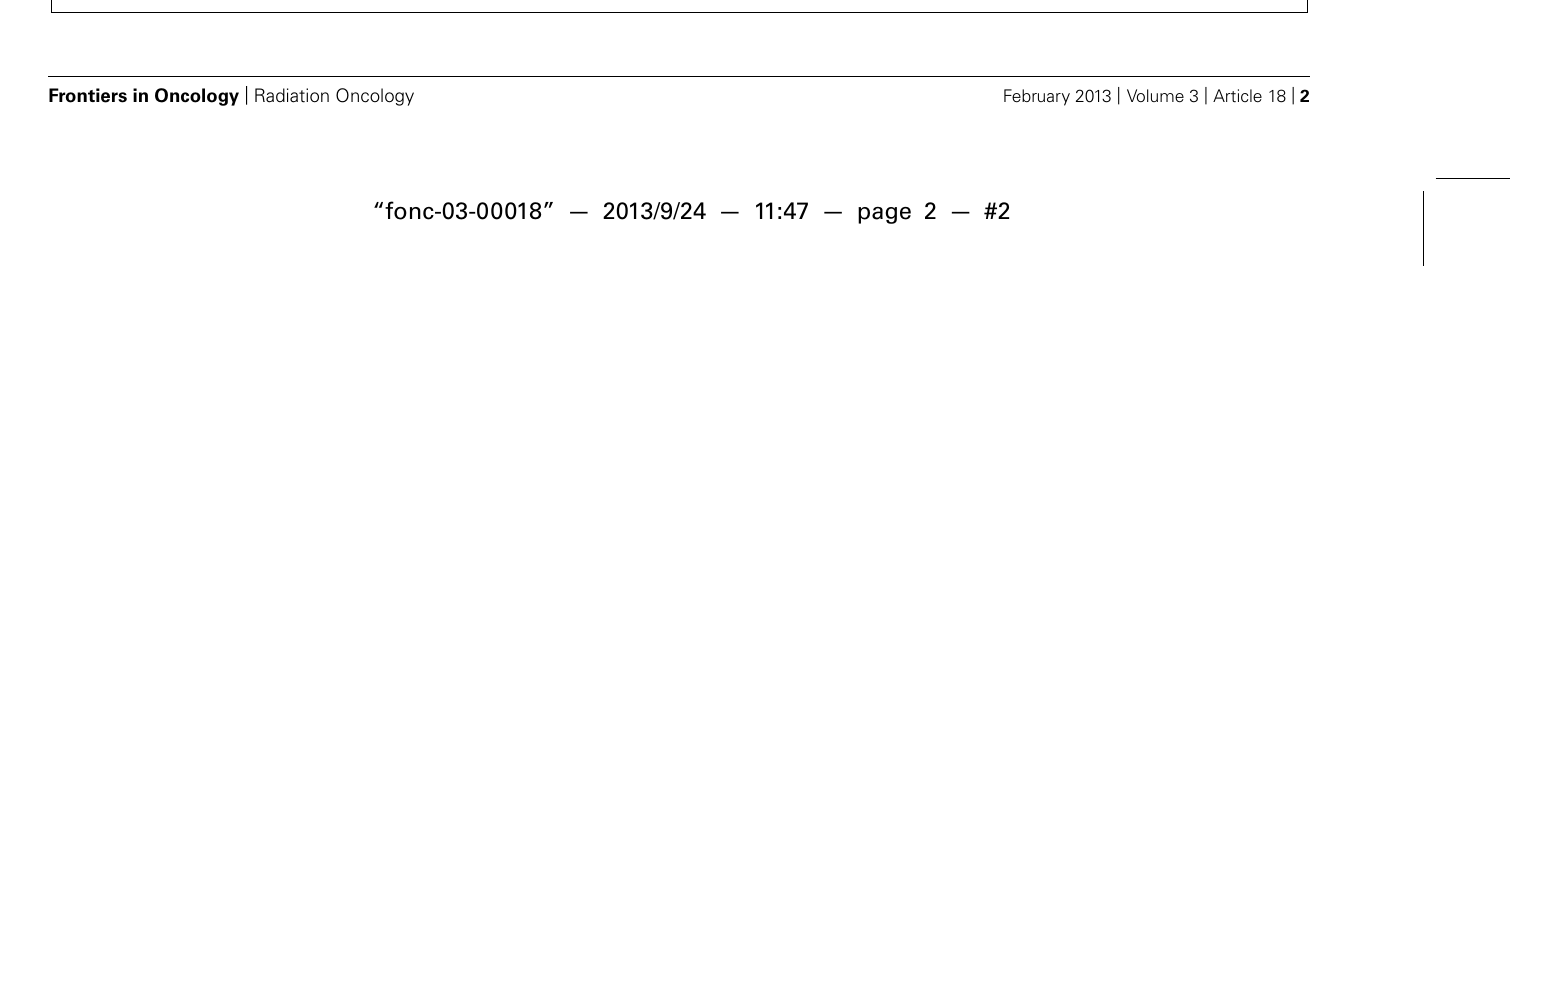
Frontiers in Oncology | Radiation